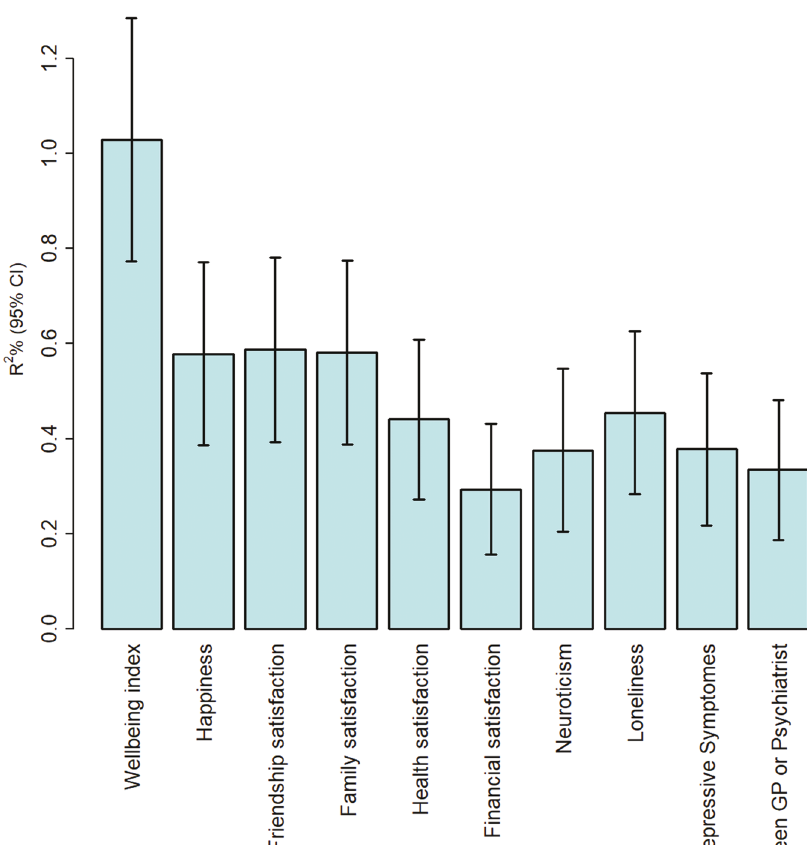
Fig. 4 Variance explained by polygenic scores derived from the wellbeing index discovery GWAS in the replication cohort for wellbeing index score, its subcomponents and related negative mental health indicators. The y-axis shows the incremental R 2 % and for binary variables (Loneliness, Depressive symptoms, and Seen GP or Psychiatrist) Nagelkerke R 2 . Error bars are lower and upper bound of 95% con fi dence intervals. While variance explained was <1%, P -values were all highly signi fi cant ( p = 3.55 × 10 − 14 – 5.68 × 10 − 56